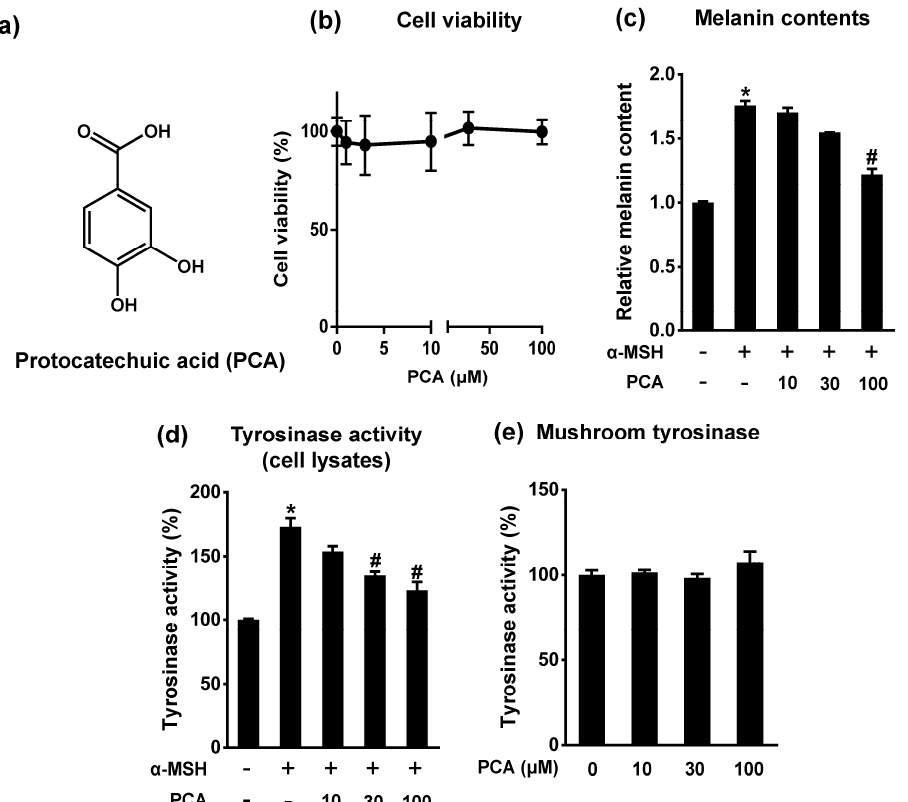
Figure 3. Effects of protocatechuic acid (PCA) on melanin synthesis and tyrosinase activity. ( a ) Structure of PCA; ( b ) B16F10 cells were treated with various concentrations of PCA for 72 h. The cell viability was measured by MTT assay; ( c ) Cells were exposed to 1 μ M α -MSH in presence or absence of PCA ( μ M) for 72 h. Melanin contents were measured with synthetic melanin as standard. * p < 0.05 vs. control; # p < 0.05 vs. α -MSH; ( d ) Cells were exposed to 1 μ M α -MSH in presence or absence of PCA ( μ M) for 24 h. Cellular tyrosinase activity. * p < 0.05 vs. control; # p < 0.05 vs. α -MSH; ( e ) Mushroom tyrosinase activity in a cell free system. Data are mean ± SEM; n = 3.